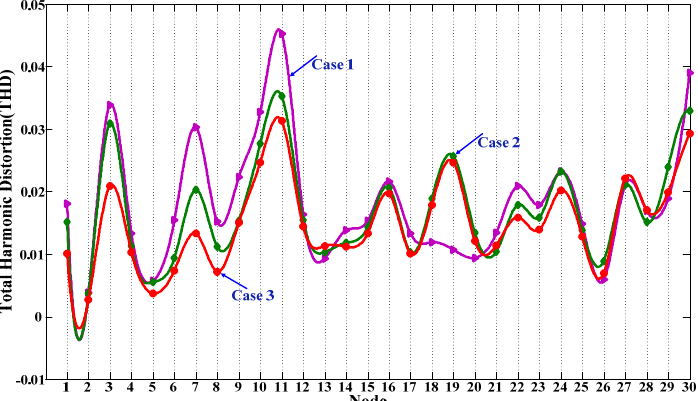
Figure 9. THD (total harmonic distortion) at each node with added DGs in case n .